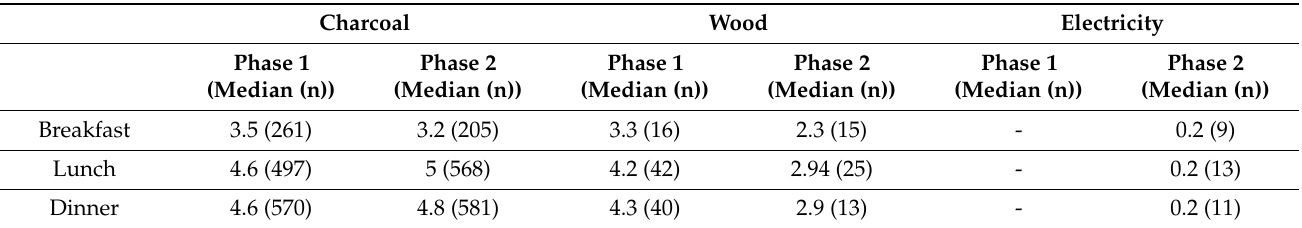
Table 13. Per capita energy consumption by meal (MJ/person/event)—single fuel heating events only (median (number of events)).